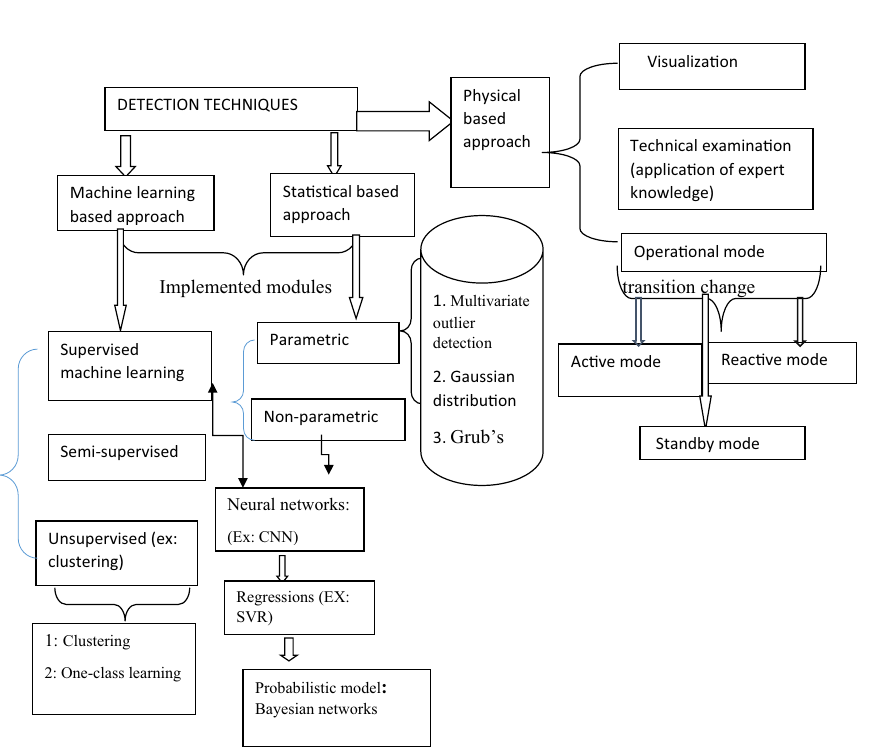
Fig. 2 Classification of detection